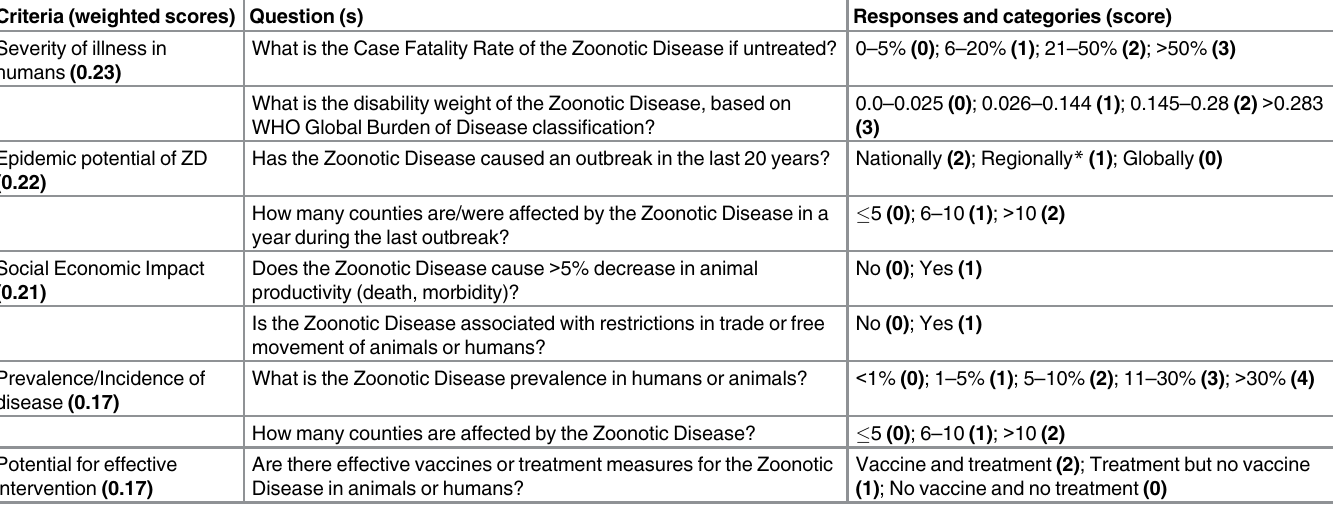
Table 1. Ranking criteria, associated weighting for each criteria, and the categorical questions for each criteria and response options used to examine each of the 36 zoonotic diseases selected for prioritization in Kenya. Criteria (weighted scores) Question